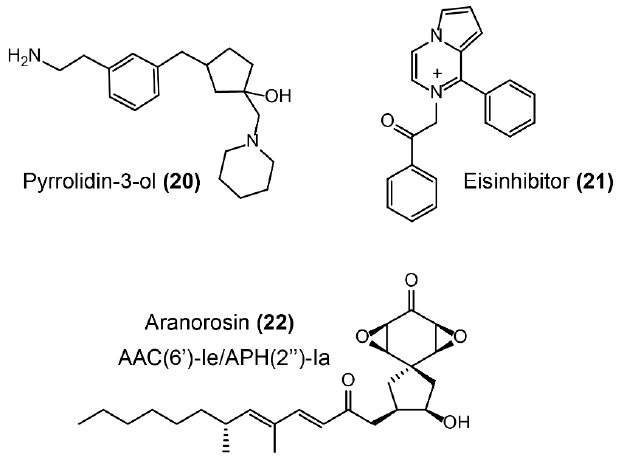
Figure 13. Inhibitors of AACs.